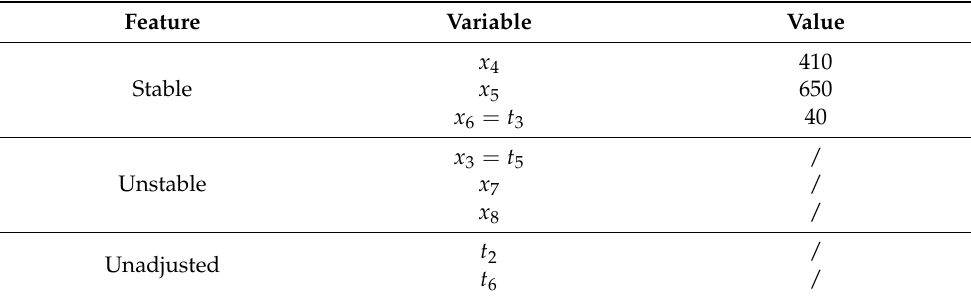
Table 12. Features of variables in the optimal operation